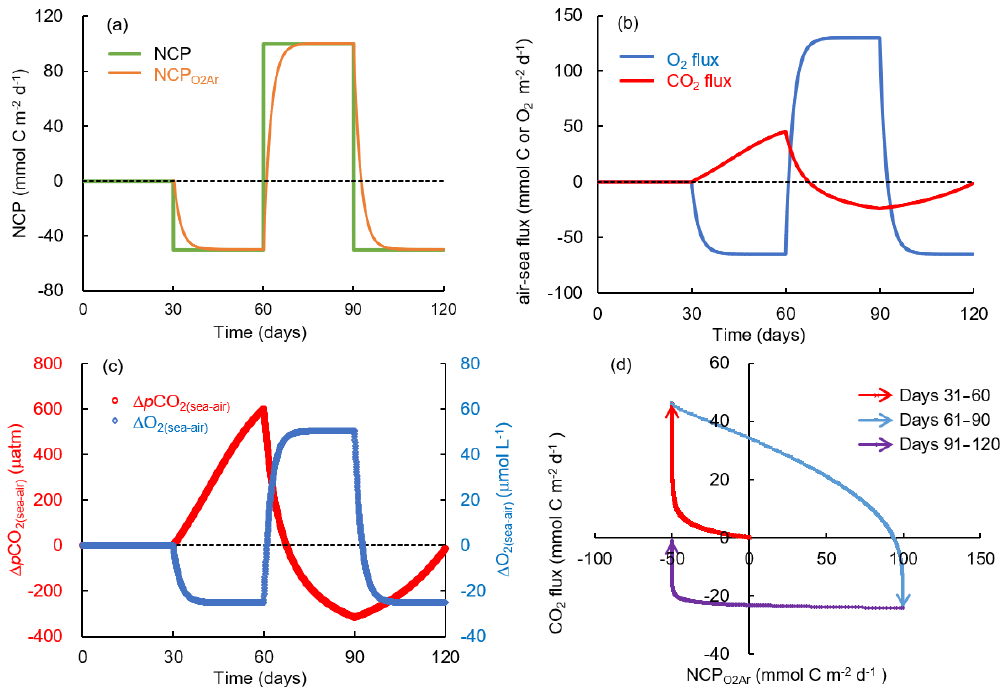
Figure 11. Simulation of carbon and oxygen dynamics responding to time-dependent varying NCP rates and gas exchange using a box model. The variations of (a) NCP and exponentially weighted NCP (NCP O ( (cid:49)p CO 2(sea–air) ) and O 2 difference ( (cid:49) O 2(sea–air) ). (d) Scatter plot of CO 2 flux and NCP O negative O 2 and CO 2 fluxes imply gas influxes into the water. See the text for